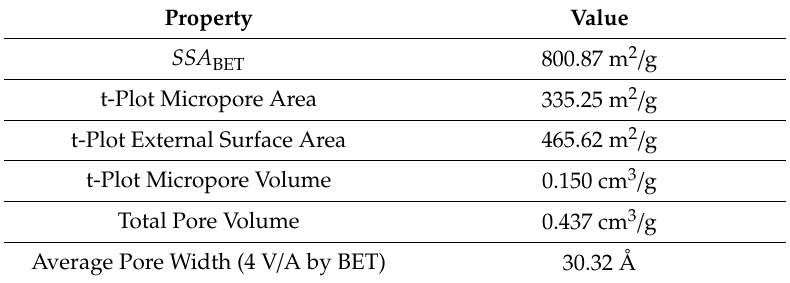
Table 3. SSA BET properties of date palm-tree branches (DPB) based activated carbon